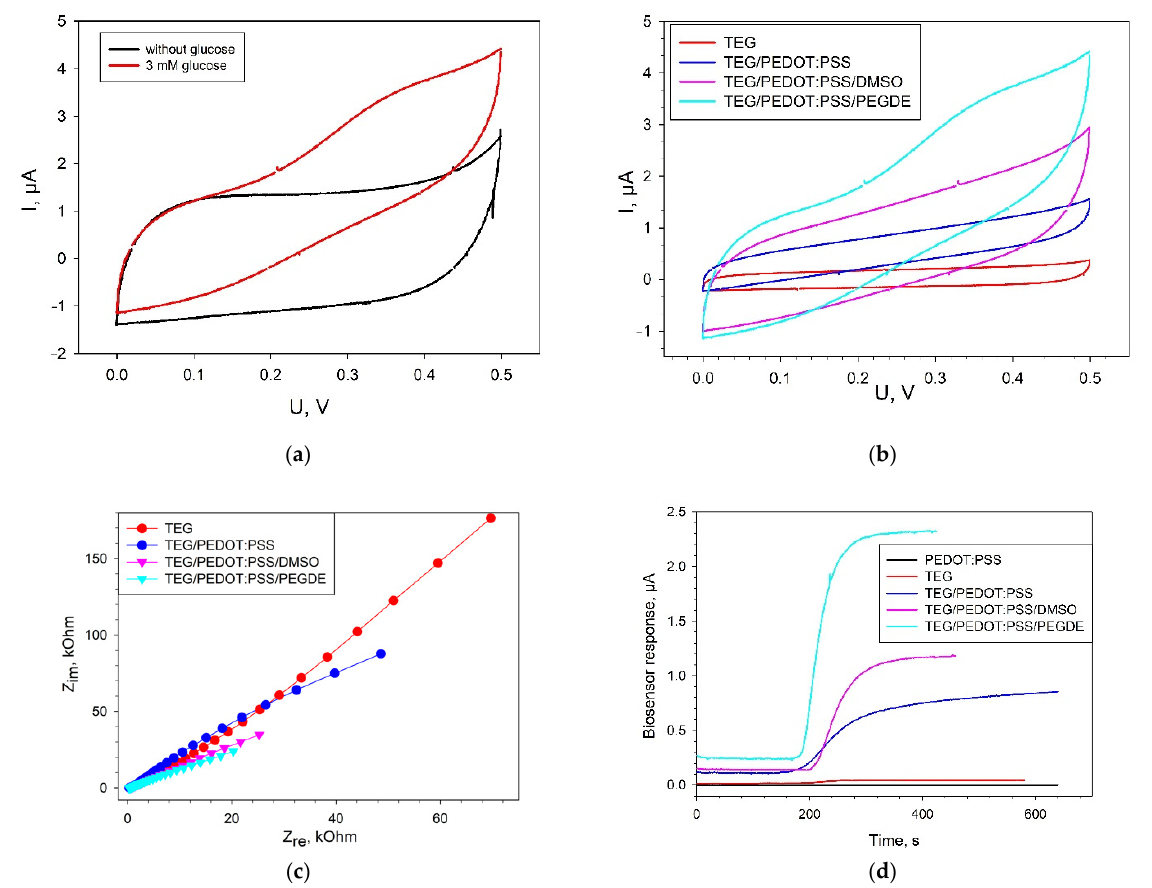
Figure 4. Electrochemical characteristics of biosensors modified with various types of PEDOT:PSS. ( a ) CVA of a TEG/PEDOT:PSS/PEGDE bioelectrode in the presence and absence of 3 mM glucose at a scan rate of 3 mV s − 1 ; ( b ) CVA of various modifications of bioelectrodes in the presence of 3 mM glucose at a scan rate of 3 mV s − 1 ; ( c ) Nyquist plots for all types of bioelectrodes; ( d ) biosensor signals in response to the addition of 3 mM glucose at an applied potential of +400 mV (vs Ag/AgCl). All measurements were made without the presence of redox mediators.